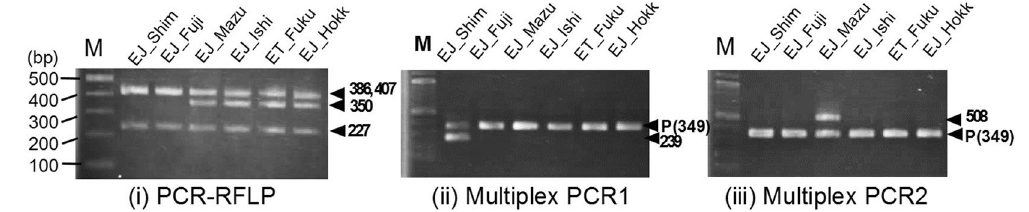
Figure 3. PCR genotyping of the three major Japanese Eutrema cultivars. Agarose gel electrophoresis of (i) PCR-RFLP for ‘Fujidaruma’ and ‘Shimane No. 3’, (ii) Multiplex PCR1 for ‘Shimane No.3’, and (iii) Multiplex PCR2 for ‘Mazuma’. Black arrowheads indicate bands of expected sizes. M: Size marker, P(349): Positive rbcL (ribulose bisphosphate carboxylase large chain) control amplicon. See Table 3 for the abbreviation of each accession